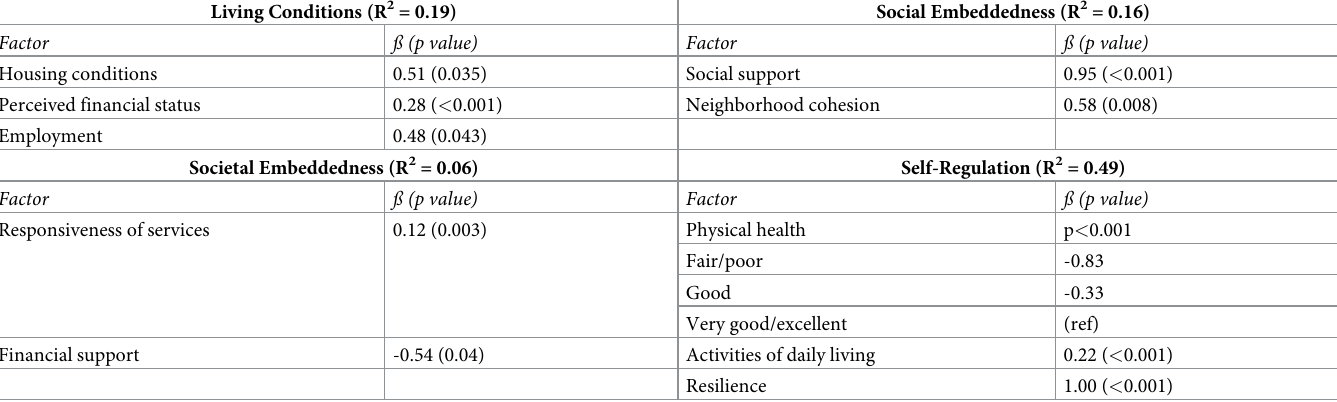
Table 4. NL condition-specific models: Factors within each condition that are independently associated with quality of life. Living Conditions (R 2 =